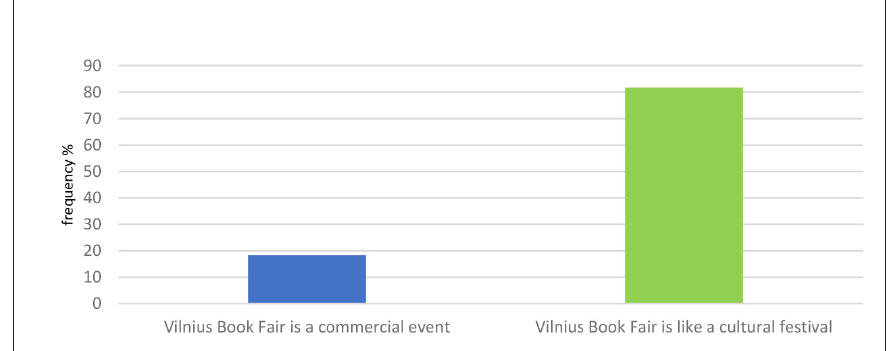
Figure 1. A statement